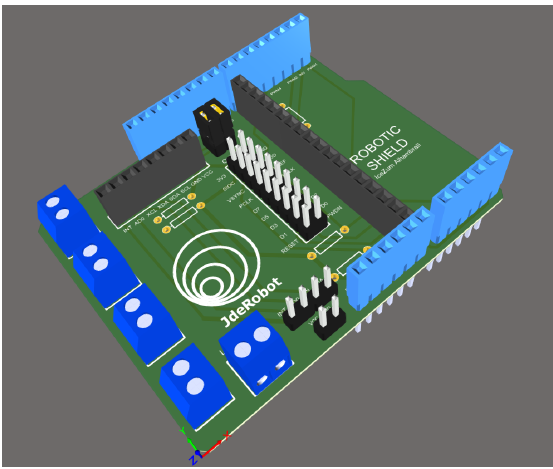
Figure 16. 3D representation of shield for IceZum Alhambra II.